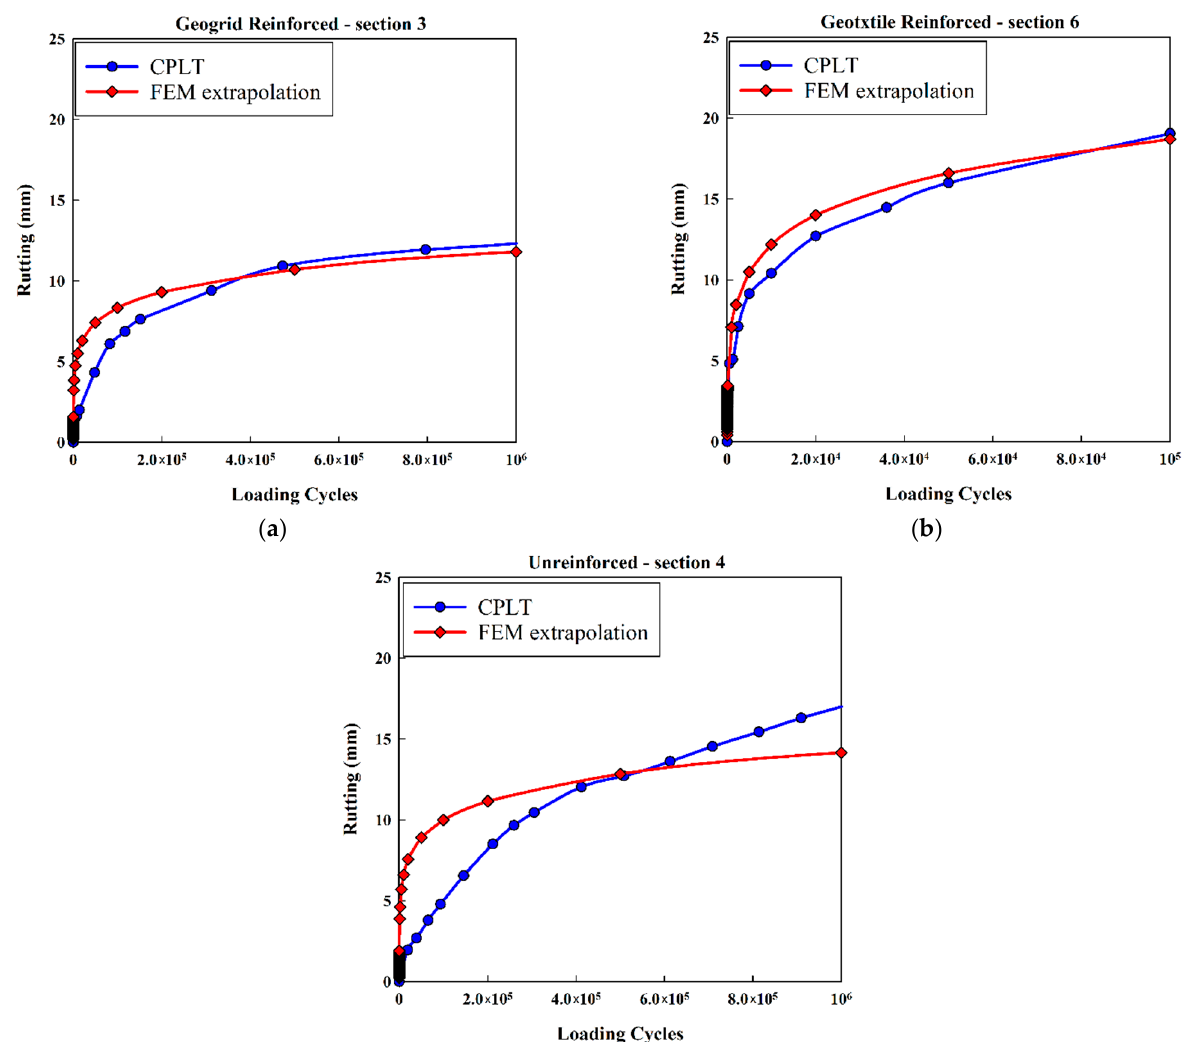
Figure 8. The comparison of the FE extrapolated rutting curves and those of CPLT for ( a ) a 49.28 cm base thickness with a geogrid, ( b ) a 26.67 cm base thickness with a geotextile, and ( c ) a 49 cm base thickness without reinforcement.